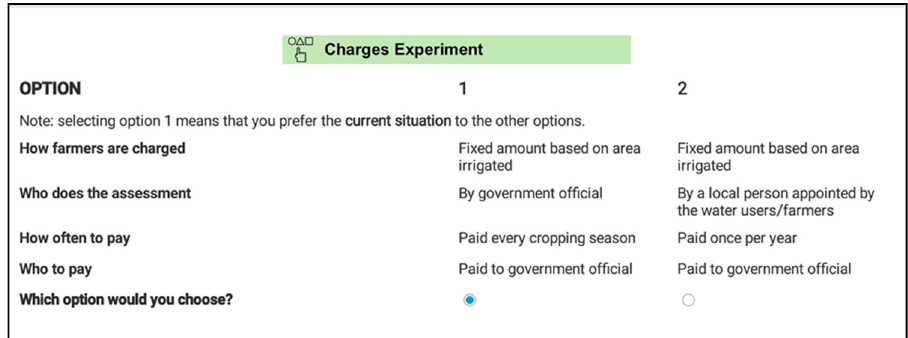
Figure 2. Example choice set: DCE 1.